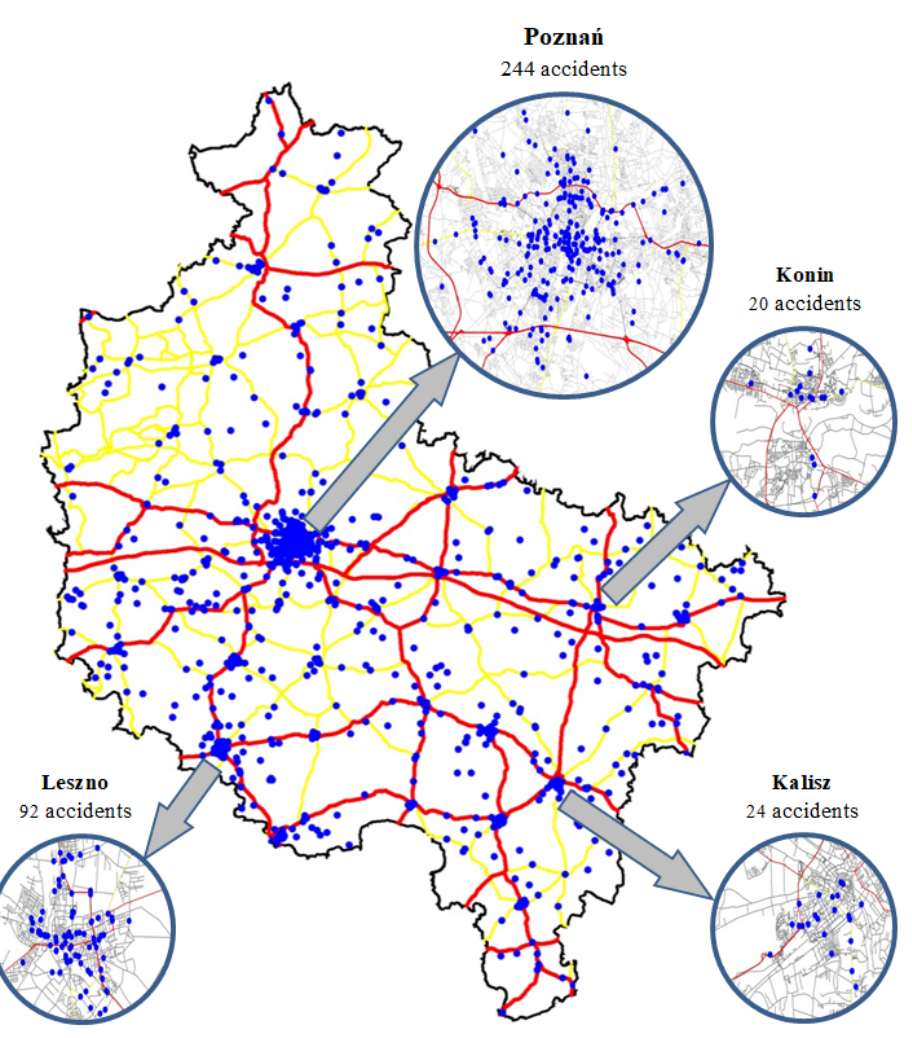
Figure 2. An example of an analysis of the location of accidents involving cyclists in 2015–2017 on the road network of the Wielkopolskie Province [18].